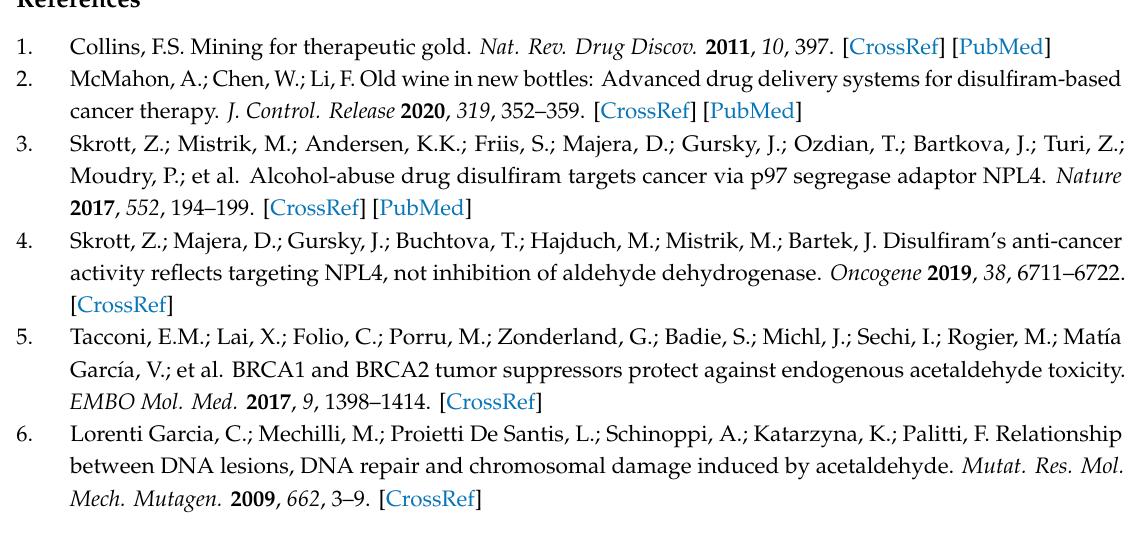
Figure S1: CuET is causing DNA damage preferentially in S / G2 cells. Figure S2.: CuET impairs DNA replication in MDA-MB-231 and U2OS cells. Figure S3: Detection of DNA breaks after CuET treatment. Figure S4: Microscopy- based quantitative analysis of fluorescence signal in